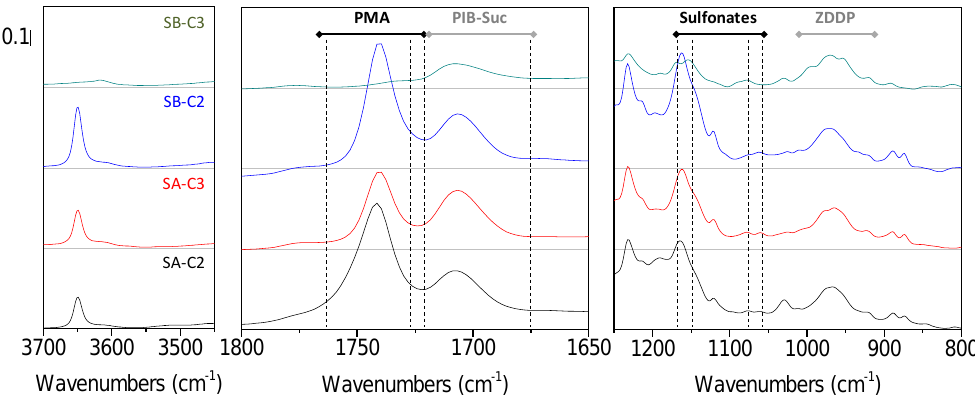
Figure 3. FTIR main features of fresh lubricants: SA-C2 (black), SA-C3 (red), SB-C2 (blue) and SB-C3 (green).